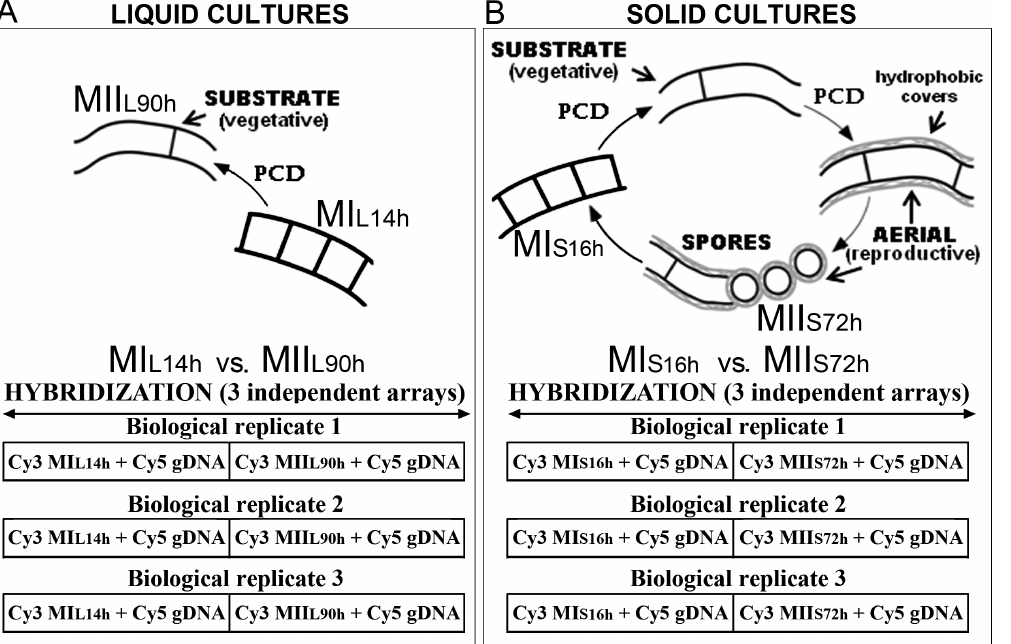
Figure 1. Streptomycescoelicolor development stages and sample preparation . (A) Liquid non-sporulating cultures. (B) Solid sporulating cultures. Mycelial structures (MI, first compartmentalized mycelium; MII, second multinucleated mycelium). The classical nomenclature of substrate, aerial mycelium, and hydrophobic layers are indicated. Three independent biological replicates and two developmental stages (MI and MII) were processed and cDNA was labeled with Cy3 while chromosomal S. coelicolor DNA was used as reference and labeled with Cy5. The scheme was adapted from Manteca et al. [12].